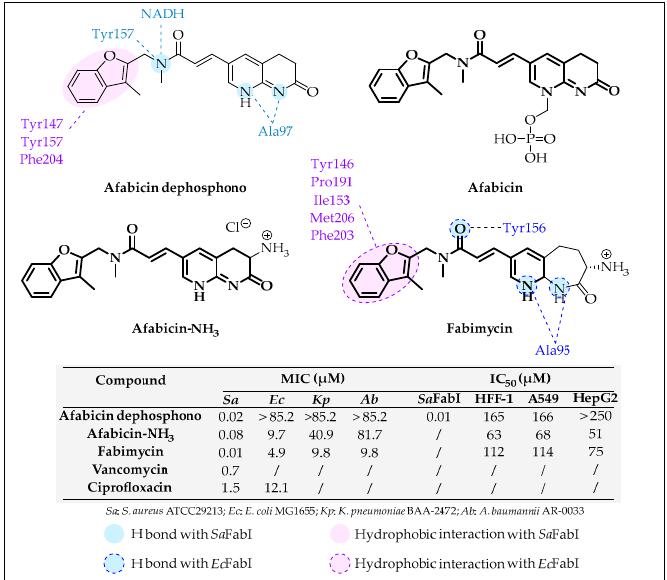
Figure 38. Structure, interactions with Sa FabI and Ec FabI and in vitro activity of afabicin dephosphono and its analogues [115,163,164].